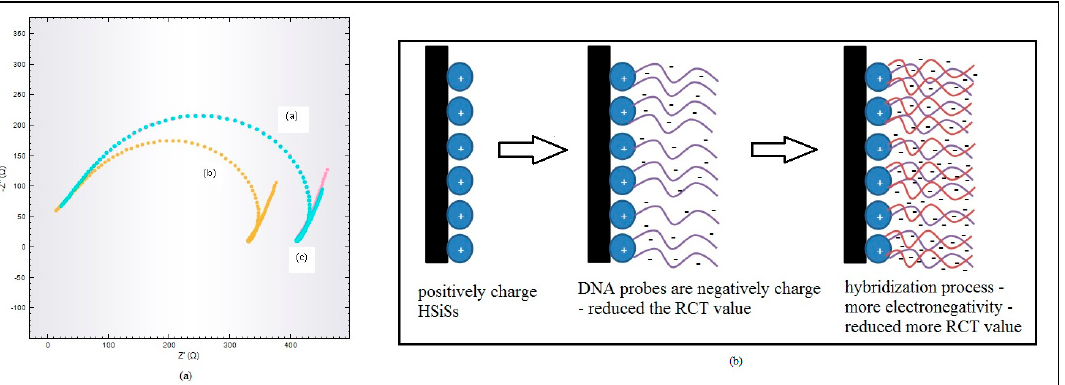
Figure 4. ( a ) Nyquist plot for probe DNA (blue line), target DNA (yellow line), and non-complementary DNA (pink line) in Na-phosphate buffer 0.05 M containing 0.1 M NaCl at pH 7. ( b ) Proposed interaction between silica (positive charge) and DNA (negative charge) before and after the hybridization process on the electrode surfaces.